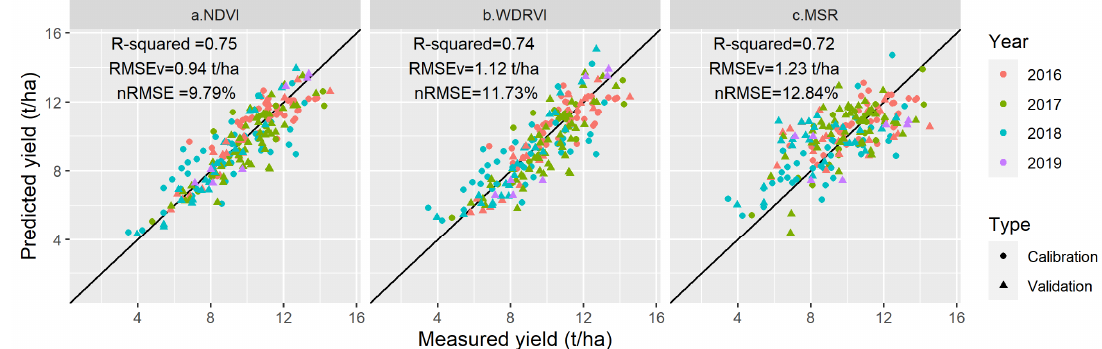
Figure 3. Relationships between measured and predicted yield under hierarchical linear modeling (HLM) using ( a ) NDVI, ( b ) wide dynamic range vegetation index (WDRVI), and ( c ) modified simple ratio (MSR).